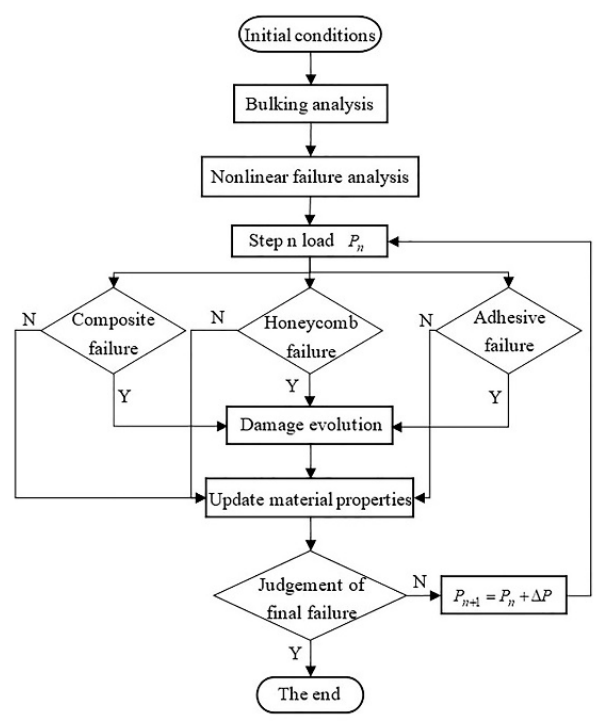
Figure 13. The progressive failure process for composite honeycomb panels.